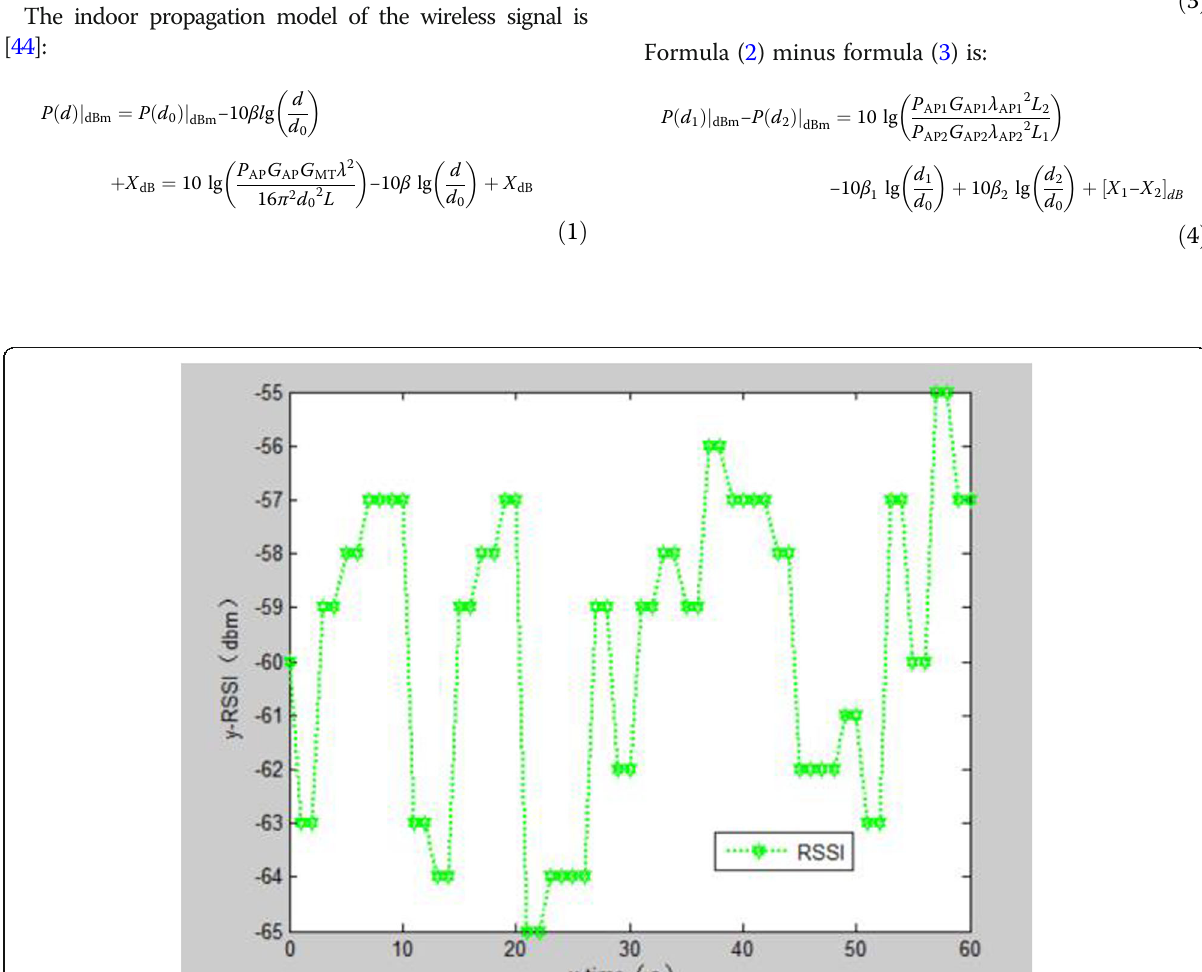
Fig. 2 RSS measured by the same device at the same location during one